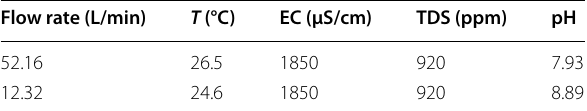
Table 2 The measurable parameters instantly for outflow brackish groundwater at two different pumps ’s flow rates